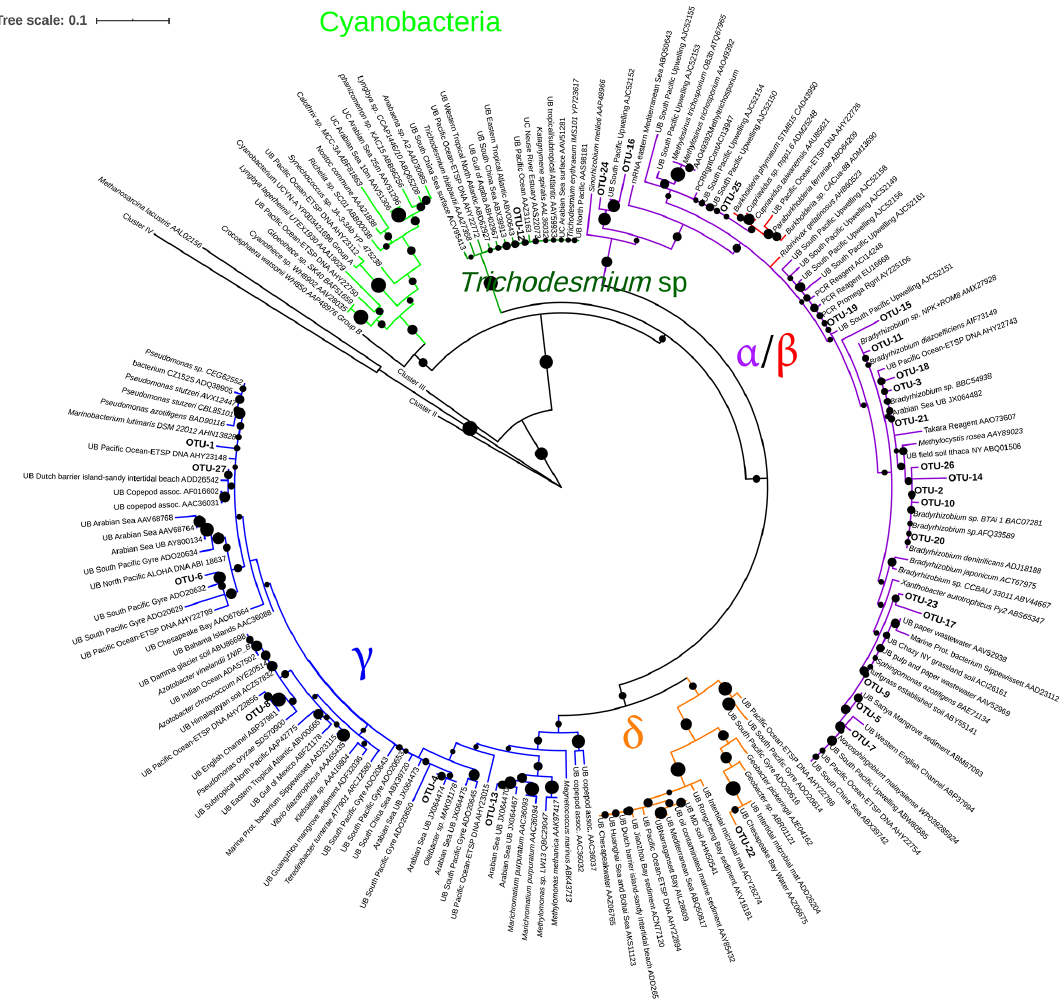
Figure 3. Maximum likelihood (ML) phylogenetic tree, based on the Poisson model, of Cluster I partial nifH -translated amino acid sequences from DNA and cDNA. Bootstrap values > 50% of 1000 replications are labeled with black circles on the branches. Accession number of reference sequences from NCBI are provided at the end of each reference name. Positions of the OTUs are shown relative to their nearest neighbors from the database. Individual sequence identities comprising each OTU are listed in Table